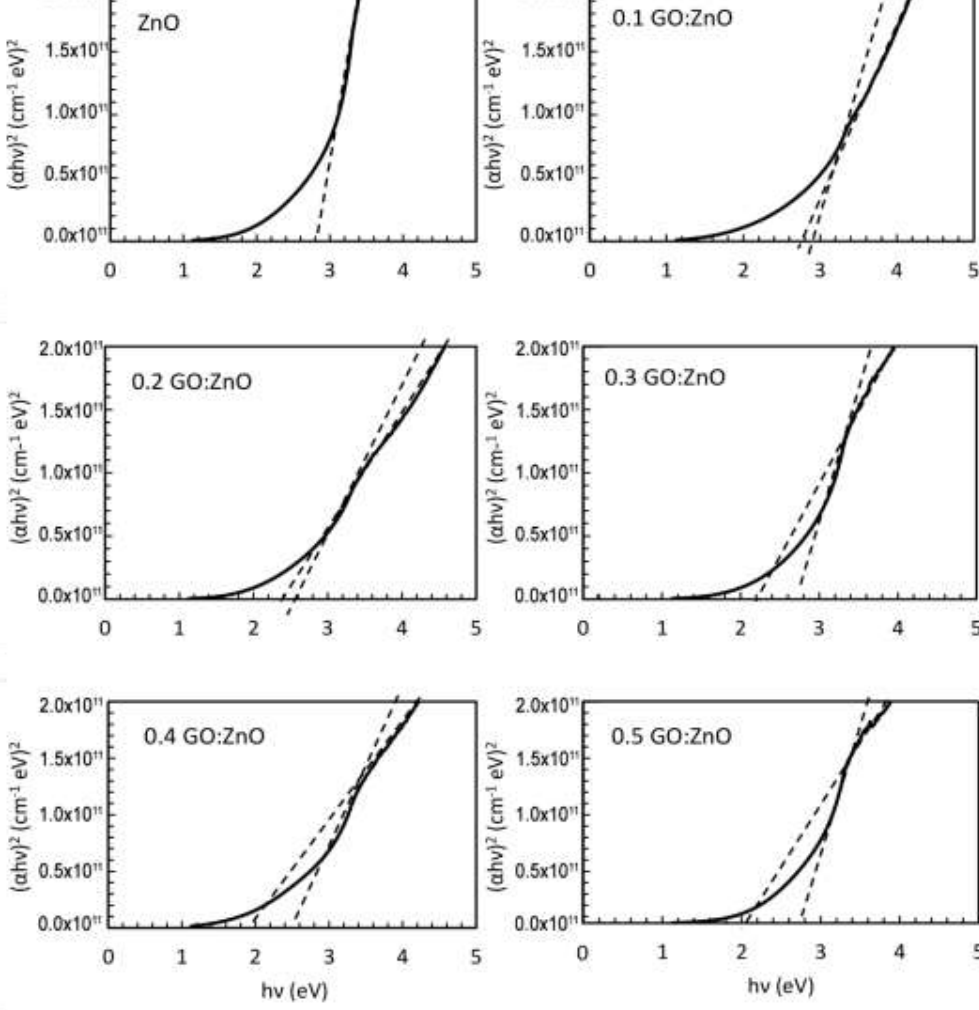
Figure 6: Plots of ( ahυ ) 2 versus ( hυ ) of the nanohybrid graphene-ZnO thin films at different